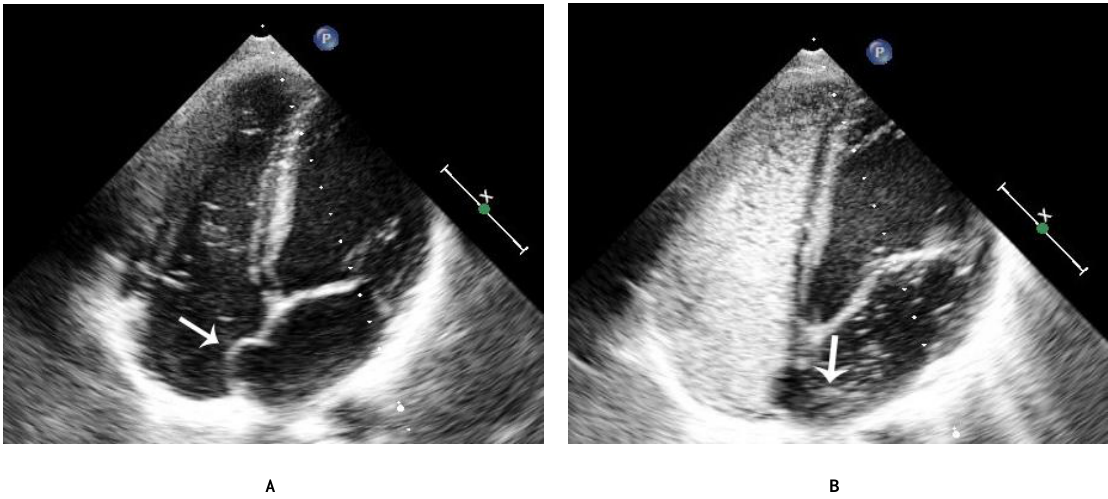
A B FIGURE 1. (A) Transthoracic echocardiography imaging revealed a typical half-moon-shaped atrial septal aneurysm (arrow) in the apical four-chamber view. (B) Incompetence of the interatrial septum is seen during contrast bolus injection. Hereby transit of contrast- medium from right to left is clearly evident